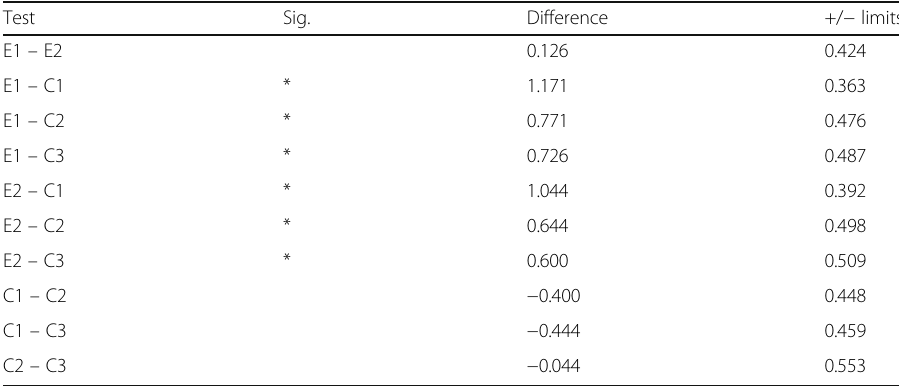
Table 6 Comparison of the mean level of progress of written production (post-treatment) Test Sig.